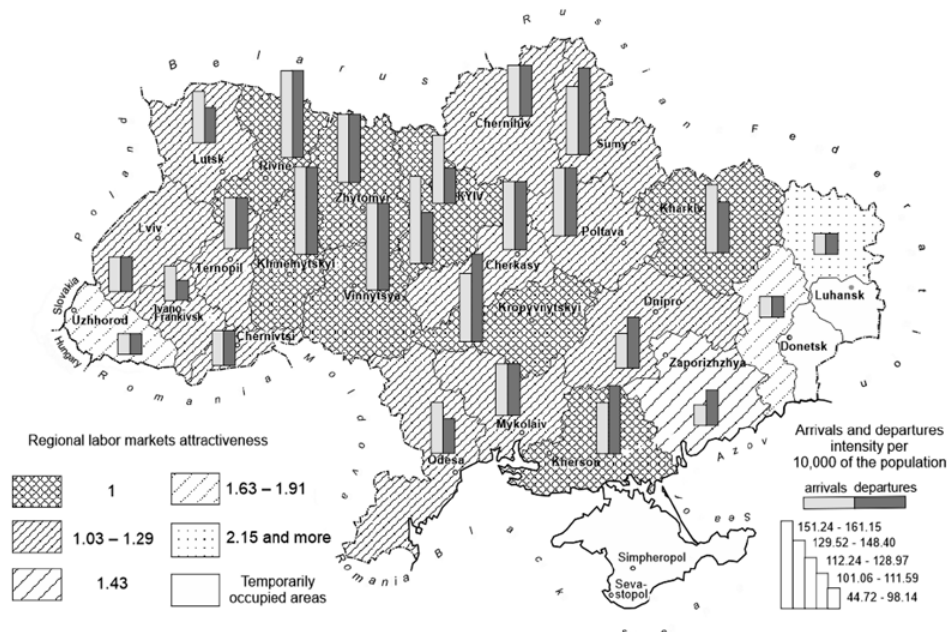
Figure 4. Migration attractiveness of Ukrainian regions: internal migration activity in terms of the labor market and employment development in